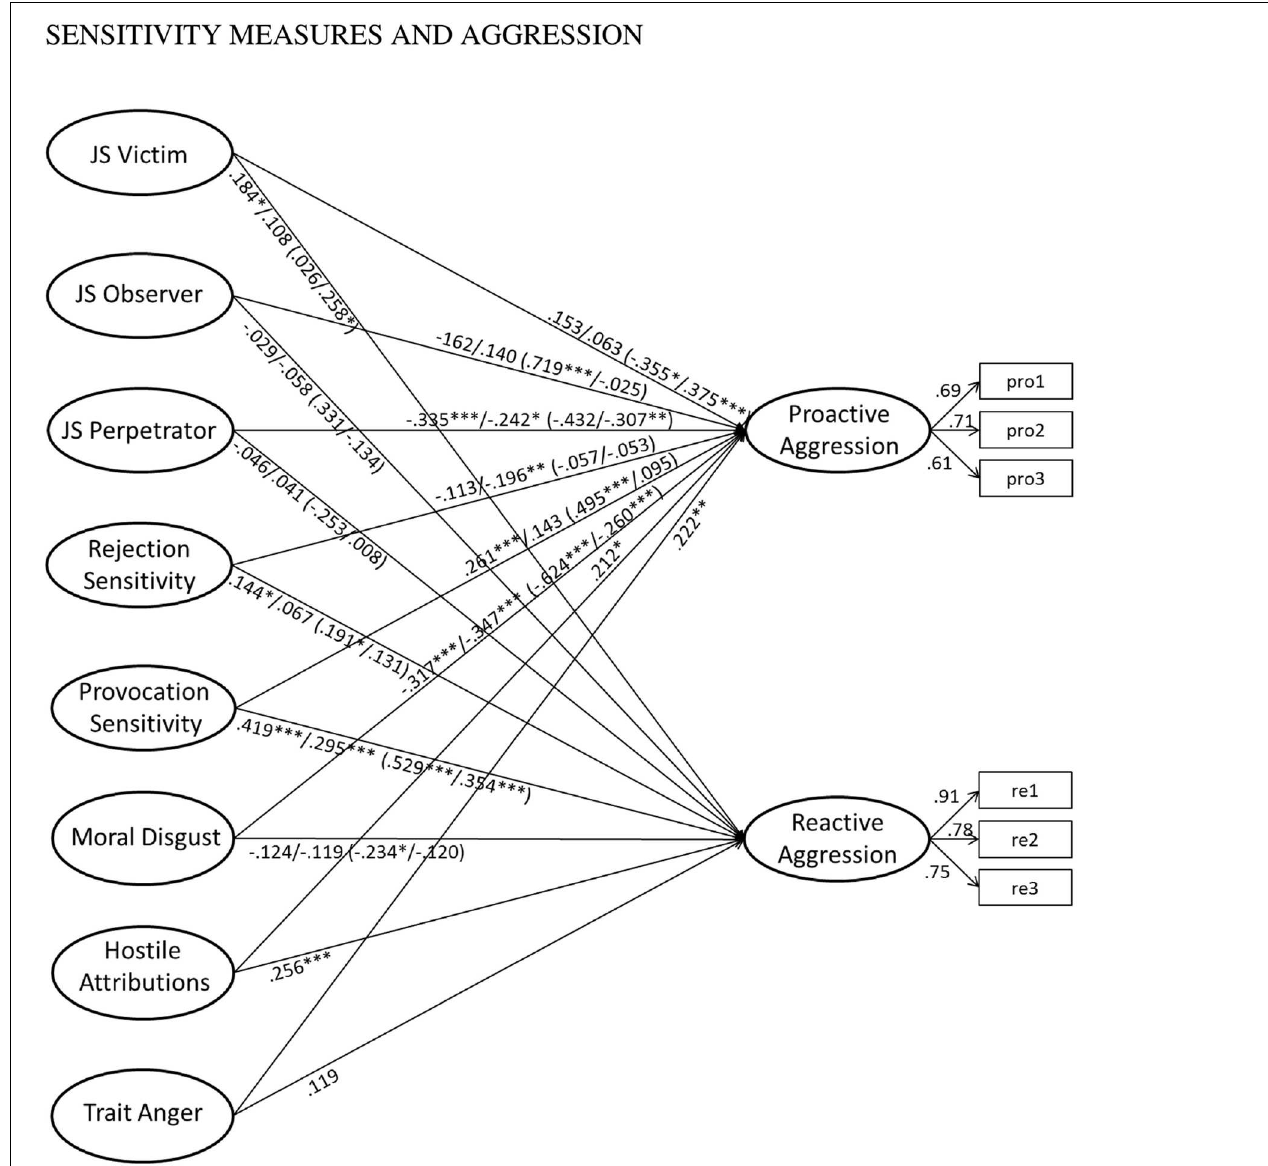
FIGURE 3 | Prediction of functions of aggression (total sample: controlled for gender and age; grouping model: controlled for age; correlations between predictors allowed and estimated; measurement model including method factor as in Figure 1). Figures in front of slashes: path coefficients for the model only including the sensitivity measures; figures after slashes: path weights for the model also including hostile attributions and trait anger. Figures in brackets: path weights for men and women respectively. Total sample (only including sensitivity measures): χ 2 = 250.652, df = 143, p < 0.001, RMSEA = 0.047, CFI = 0.958, SRMR = 0.044, N = 339; Total sample (also including hostile attribution bias and trait anger): χ 2 = 310.093, df = 208, p < 0.001, RMSEA = 0.038, CFI = 0.967, SRMR = 0.041, N = 339; Grouping by gender (only including sensitivity measures): χ 2 = 429.226, df = 286, p < 0.001, RMSEA = 0.054, CFI = 0.948, SRMR = 0.060, N =